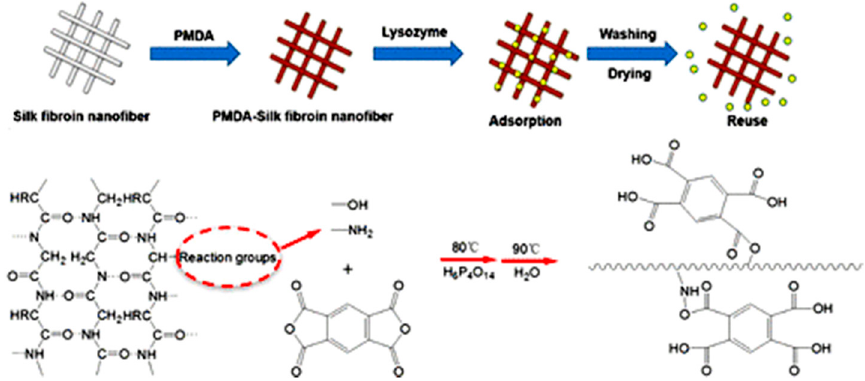
Figure 3. Graft reactions between silk and PMDA for lysozyme adsorption (adapted from [22] with the permission of American Chemical Society).